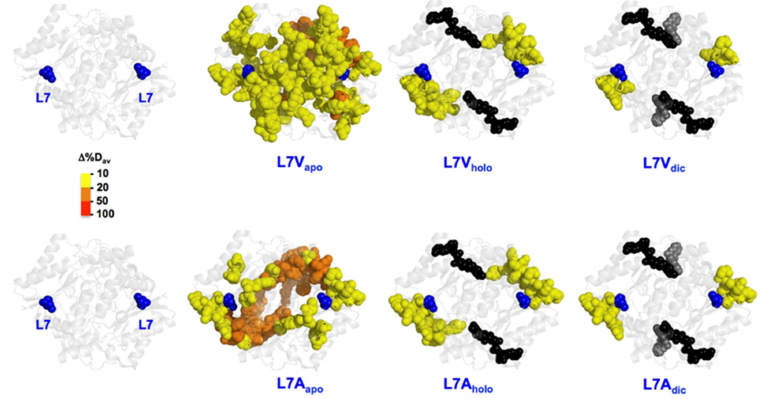
Figure 6. Representation of the changes in local stability (as ∆ %D av ) due to mutations L7V and L7A vs. WT. Results are shown as indicated in the color scale for different ligation states (NQO1 apo , NQO1 holo and NQO1 dic ). FAD and Dic are shown as spheres (black and grey, respectively). The structural model used for display was PDB 2F1O [25].